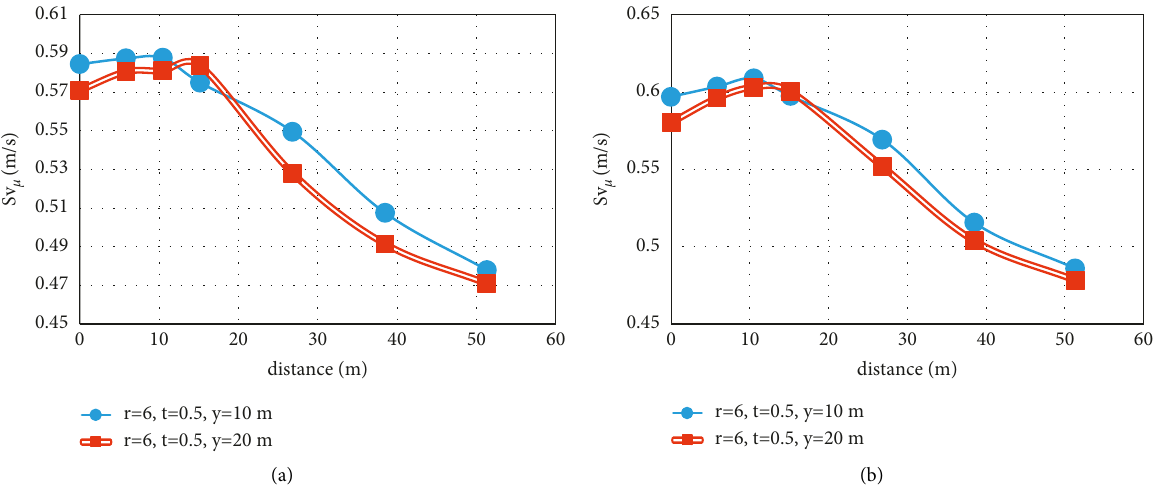
Figure 9: The effect of change in overburden depth on ground surface velocity for models (a) 8 and 9 and (b) 13 and 14 of Table 1.